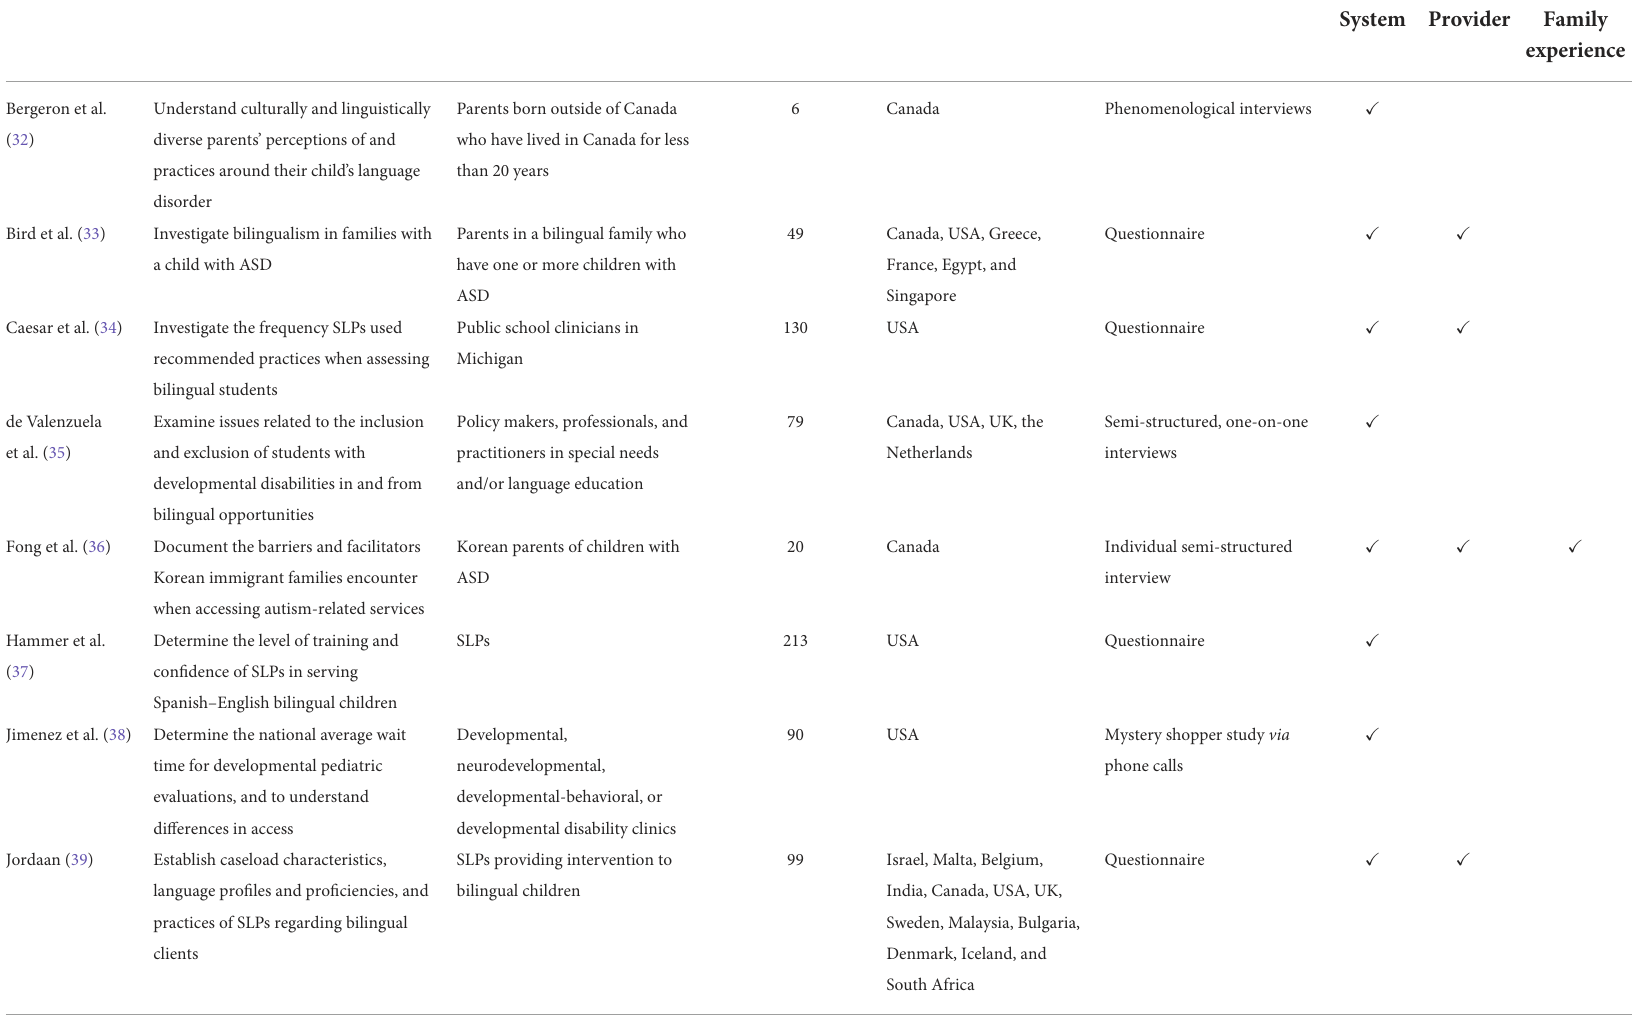
TABLE 3 Characteristics of included